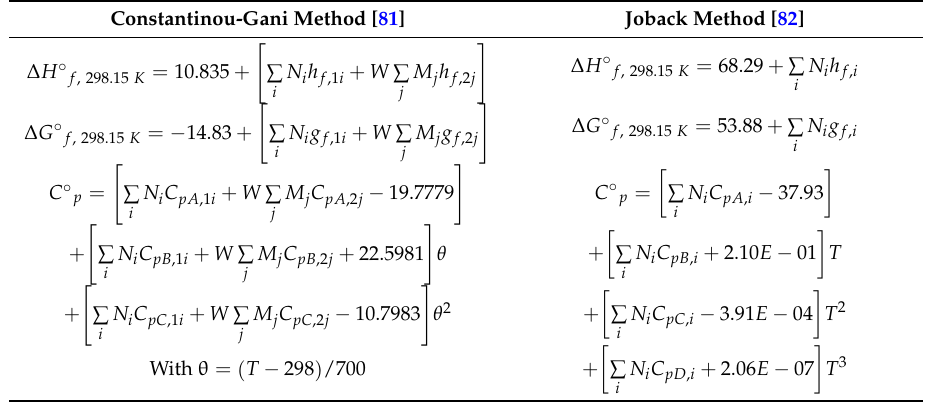
Table A1. Equations for the estimation of thermodynamic properties by group contribution methods. Constantinou-Gani Method [81] Joback Method [82] ∆ H ◦ f , 298.15 K = 10.835 +